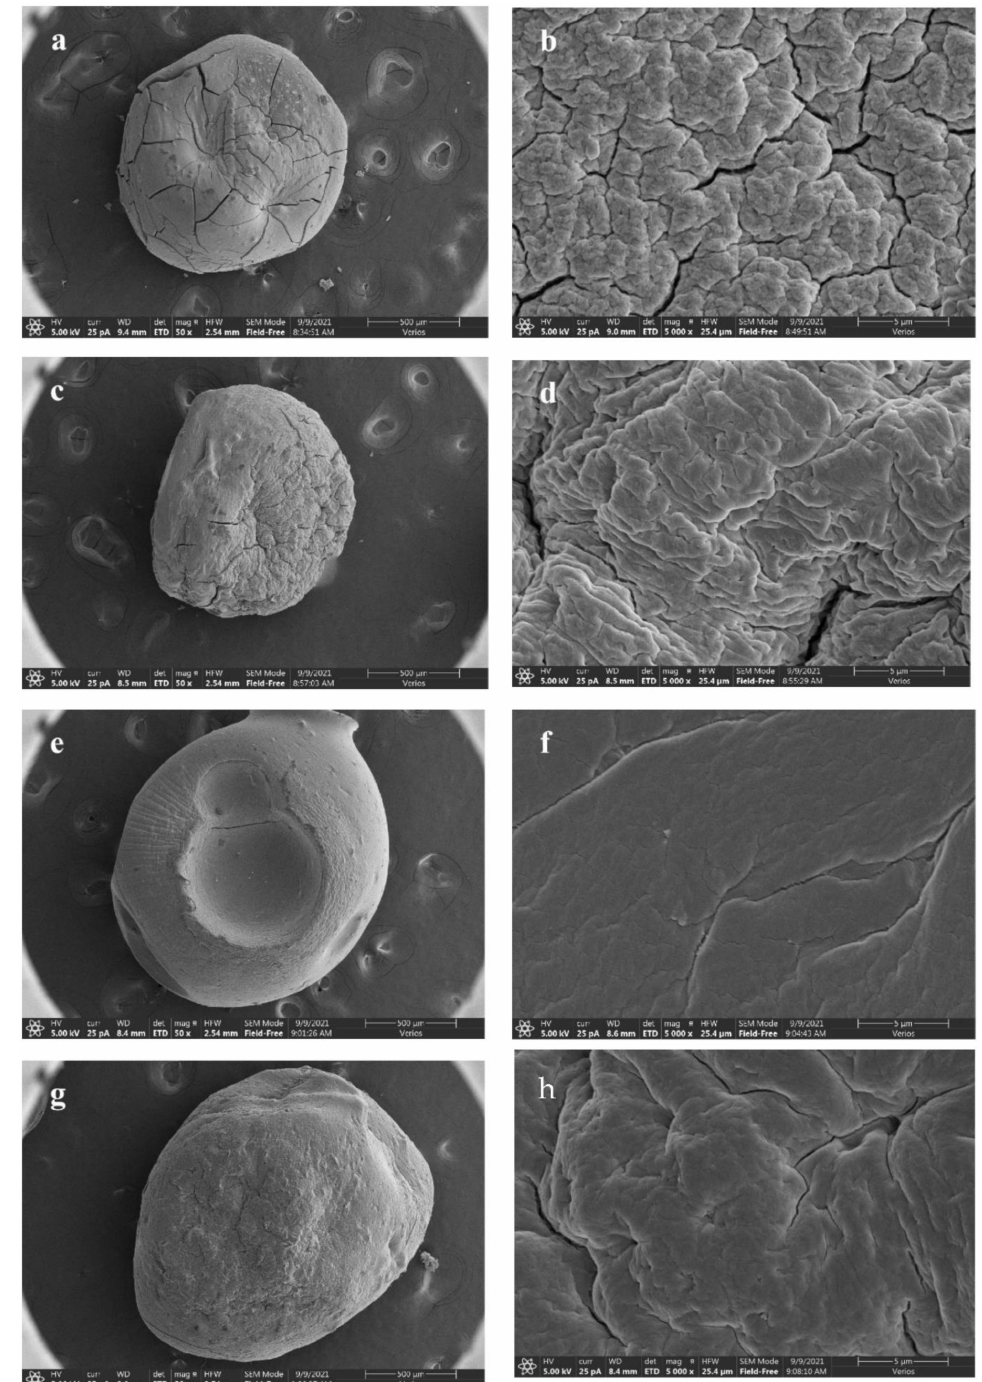
Figure 4. Scanning electron micrograph and surface morphology of ( a , b ) SA bead, ( c , d ) SCN bead, ( e , f ) SCT bead, and ( g , h ) SCC